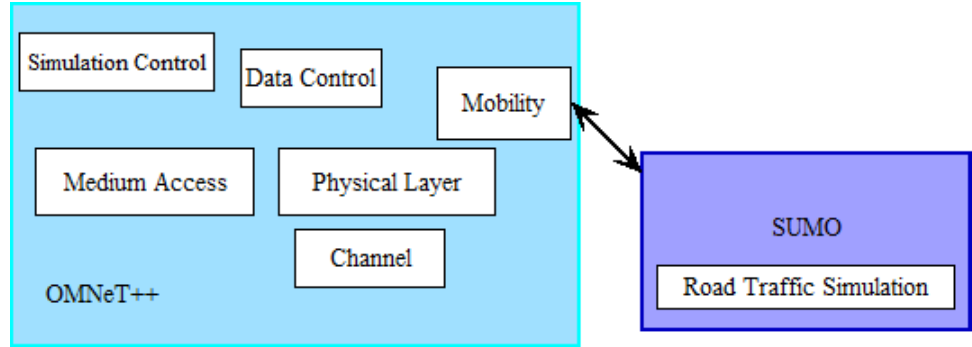
Figure 3. Objective Modular Network NESTbed in C++ (OMNeT++) with simulation of urban mobility (SUMO) [16].